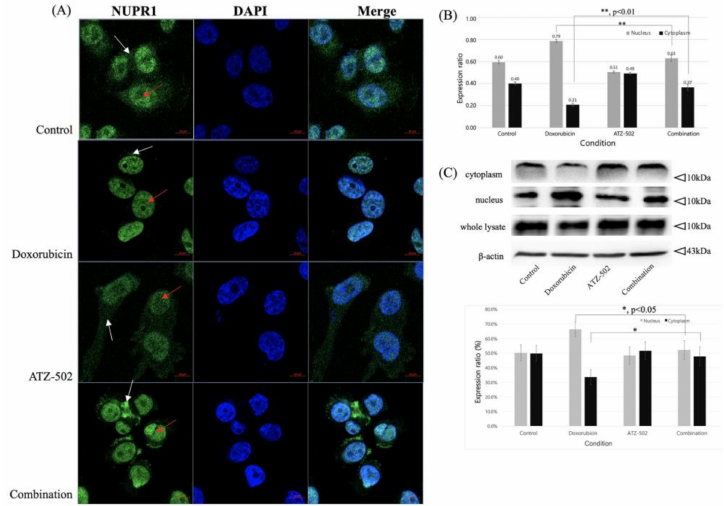
Figure 3. Changes in NUPR1 cellular localization after combination treatment to MDA-MB231 cells. The breast cancer cell line MDA-MB-231 was treated with doxorubicin only and doxorubicin plus ATZ-502 combination for 4 h. ( A , B ) NUPR1 protein was located within both cytoplasm and nucleus. The doxorubicin and ATZ-502 single-treated cells were grown in the presence of 1 µ M doxorubicin and 1 µ M ATZ-502, respectively. The combination-treated cells were grown in the presence of 1 µ M each of doxorubicin and ATZ-502 for 2 h. Cellular localization of NUPR1 was observed under a confocal microscope. Images were obtained using a ZEISS LSM 800 confocal microscope and visualized to assess protein localization. ( C ) NUPR1 and karyopherin β 1 protein expression levels in nucleus and cytoplasm using Western blot analysis. White arrow, cytoplasm; Red arrow, nucleus. *, p < 0.05; **, p < 0.01; bars,